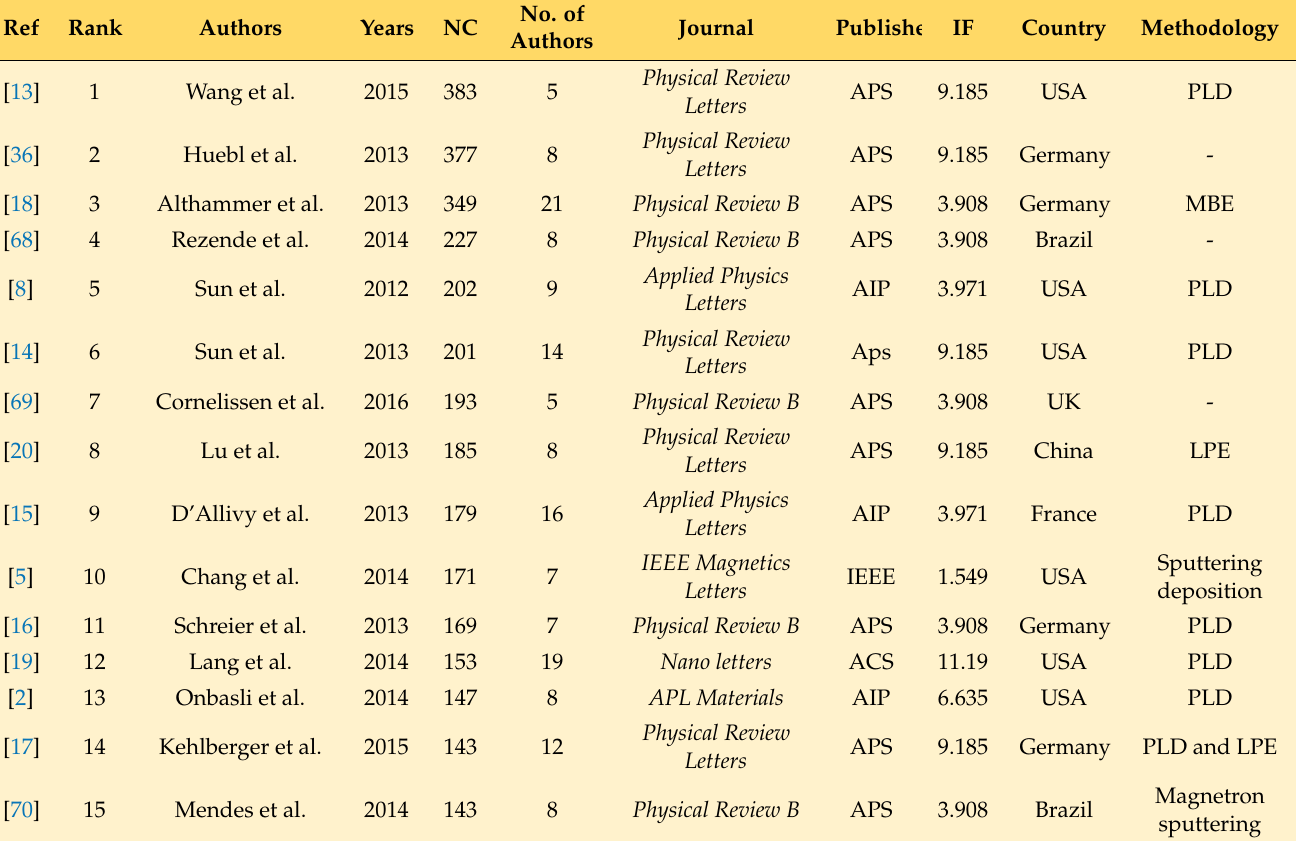
Table 1. The top 100 papers in the field of yttrium iron garnet, ranked from highest to lowest by number using the Scopus database.